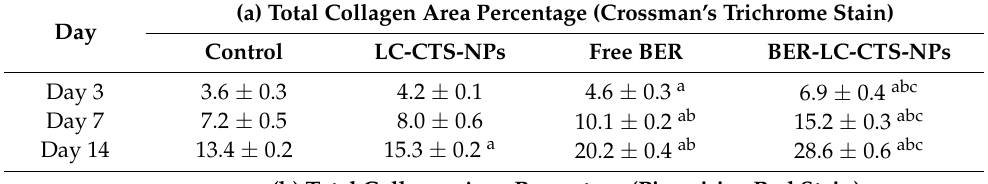
Table 5. Microscopic evaluation for collagen fiber quantification during the healing process in the diabetic rats of all studied groups; by measuring the area percentage of total collagen fibers using sections stained with Crossman’s trichrome stain × 100 ( a ) and Picrosirius red stain (bright-field view) × 100 ( b ), and measuring the area percentage of mature collagen fibers using sections stained with Picrosirius red stain (Polarized-field view) × 200 ( c ). Data were expressed as mean ± SD ( n =